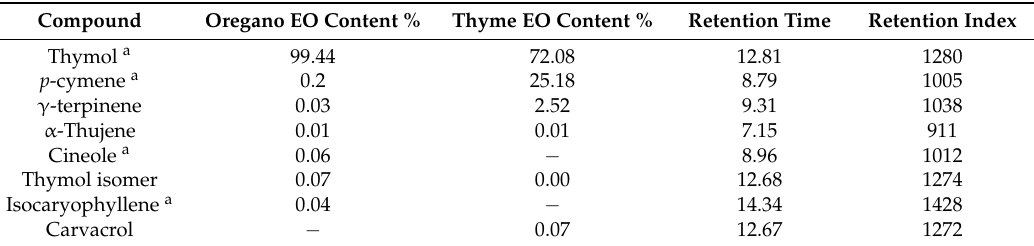
a represents volatiles compared with authentic